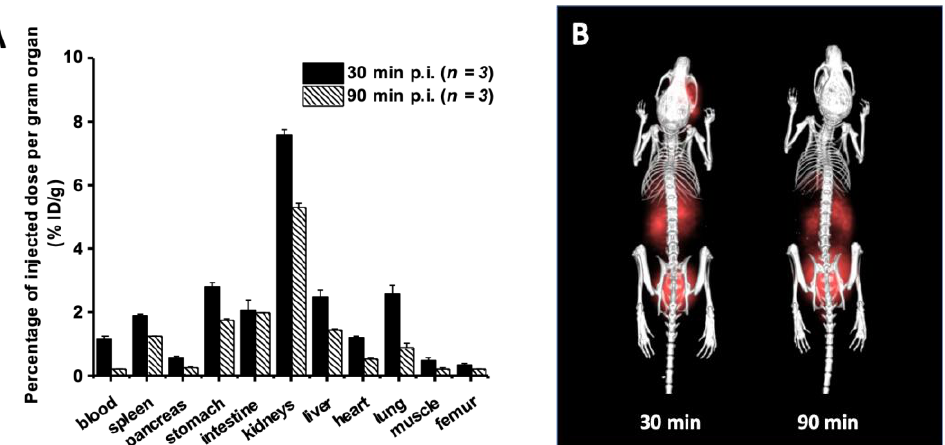
Figure 3. Ex vivo biodistribution of [ 68 Ga]Ga-DFO-c(RGDyK) in healthy Balb/c mice 30 and 90 min after r.o. injection ( A ). Static PET/CT imaging (3D volume rendered images) of [ 68 Ga]Ga-DFO- c(RGDyK) in healthy Balb/c mice 30 and 90 min after r.o. injection ( B ).